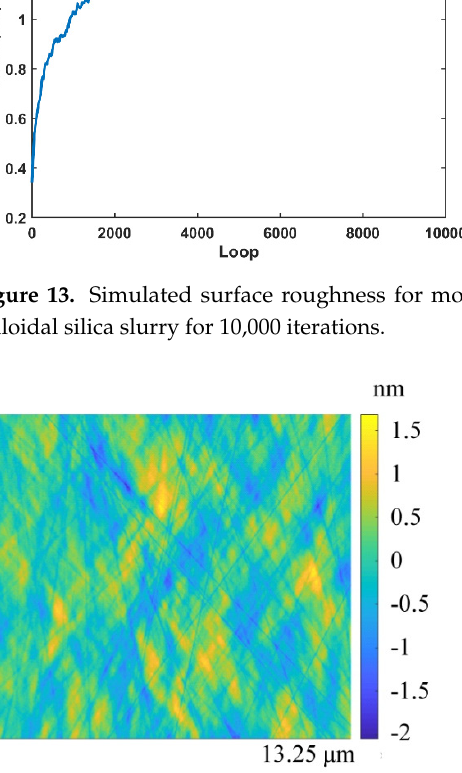
Figure 13. Simulated surface roughness for monocrystalline silicon after repolishing with pure col- loidal silica slurry for 10,000 iterations.